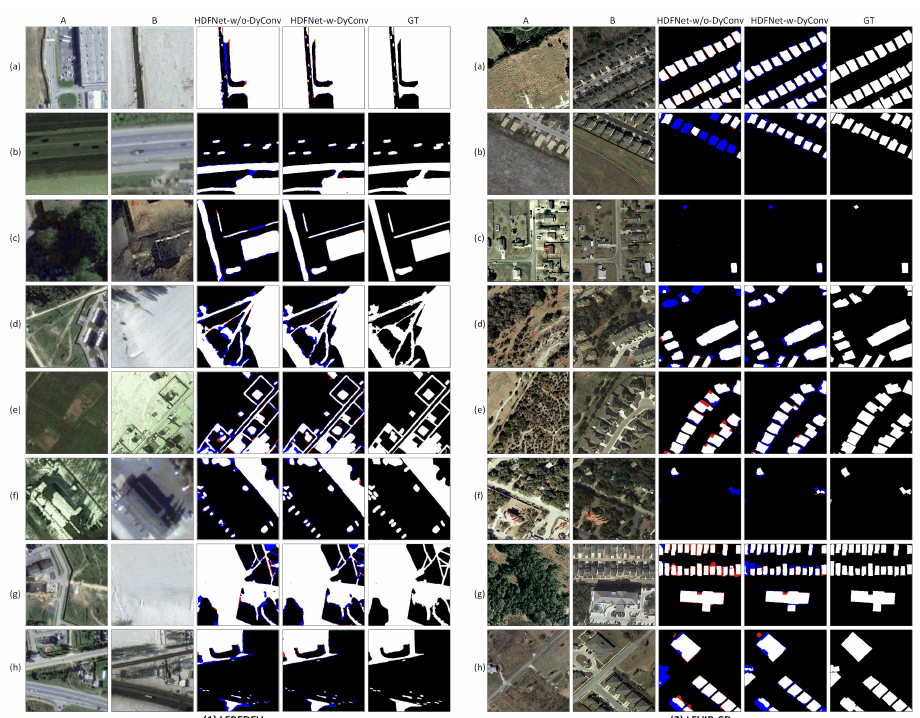
Figure 10. Qualitative ablation study on with/without dynamic convolution modules of HDFNet on both datasets, represented in (1) LEBEDEV and (2) LEVIR-CD. We select samples ( a – h ) from each dataset. White indicates the changes detected correctly. Black indicates the no change detected correctly. Red indicates the false alarms. Blue indicates unpredicted